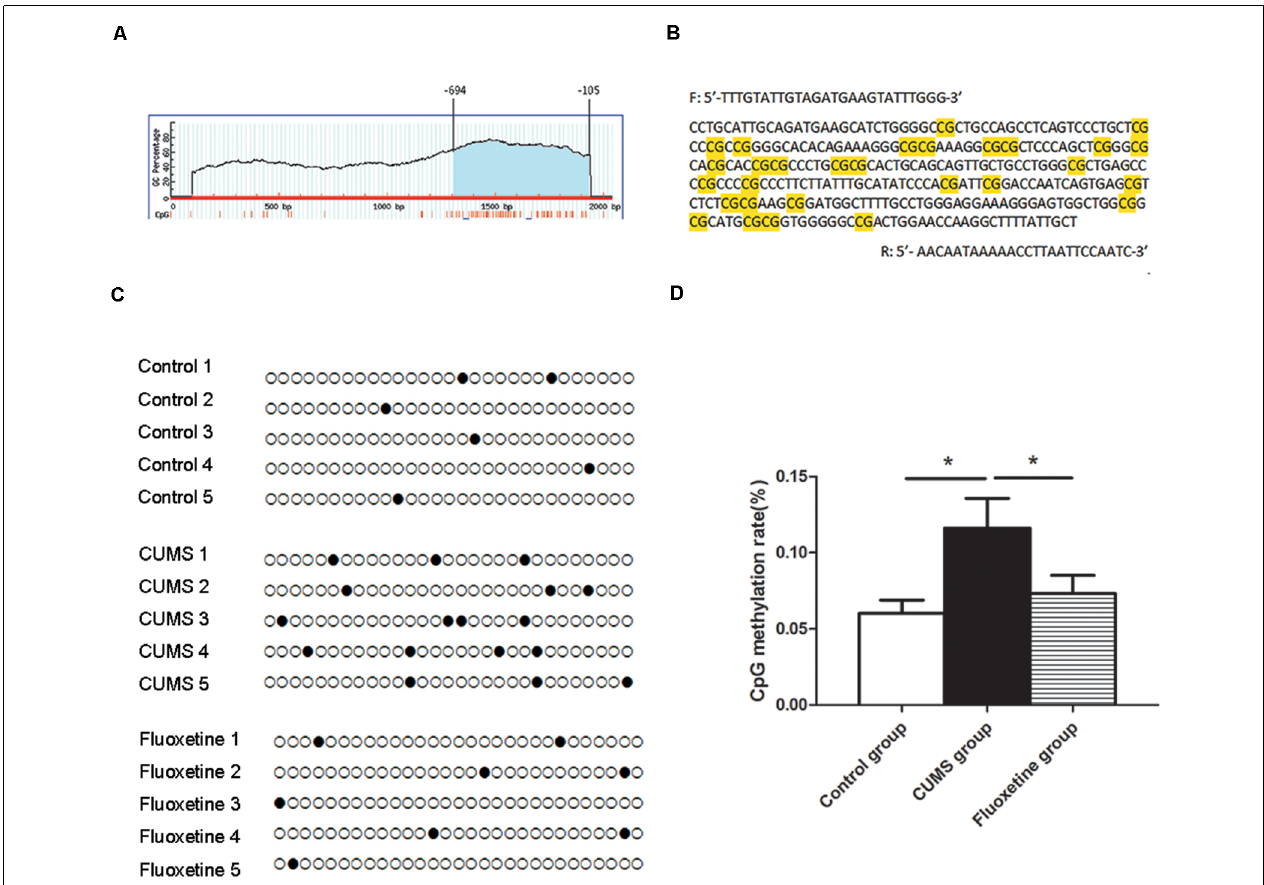
FIGURE 3 | Effect of CUMS and fluoxetine treatment on DNA methylation in the CRMP2 promoter: 1 CpG island region located from − 694 to − 105 with 29 CpG sites was identified based on the CRMP2 promoter sequence (A) ; BSP primer targeted the CpG islands in the promoter region of CRMP2 was designed, and the CpG dinucleotides are highlighted (B) ; the methylation levels of the promoter region of the CRMP2 gene in the hippocampus (C,D) , black circles represent methylated CpG sites, and white circles represent unmethylated CpG sites. * P < 0.05.